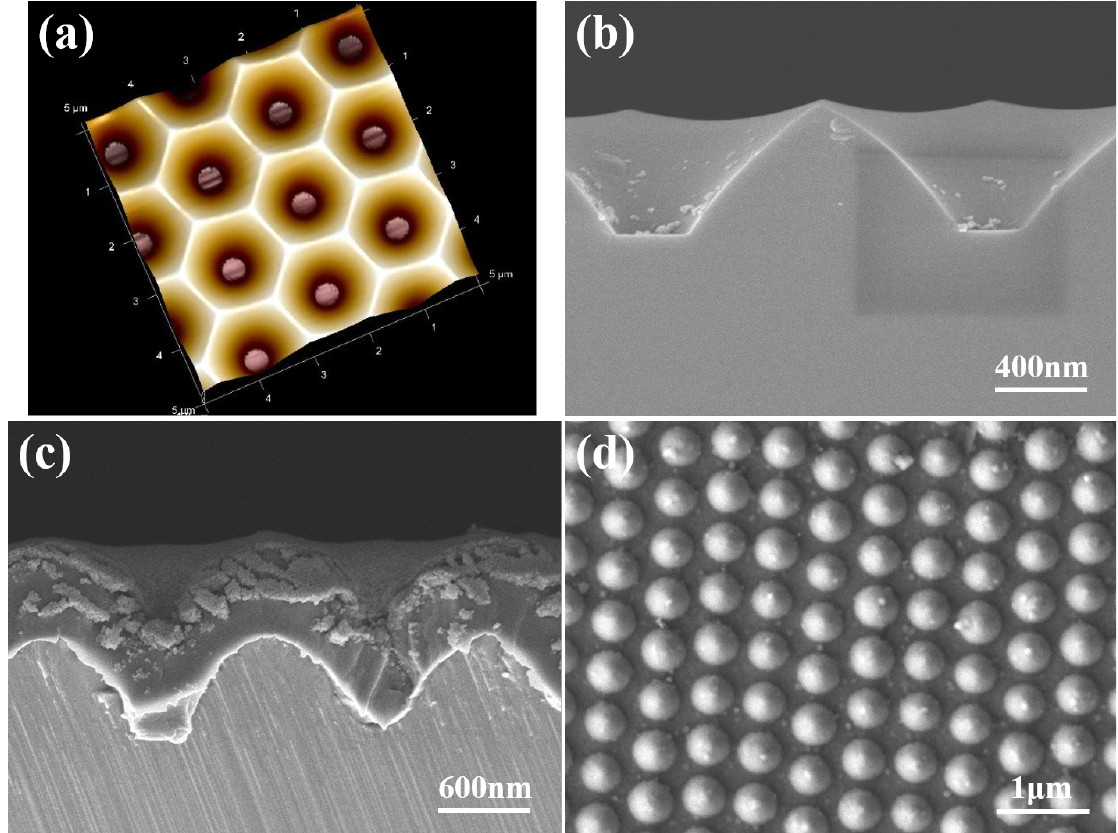
Figure 1. ( a ) A schematic diagram and ( b ) a cross-sectional image of a two-inch sapphire substrate. ( c ) A cross-sectional image of the deposited seed layer, and ( d ) a top view of a prepared patterned seed